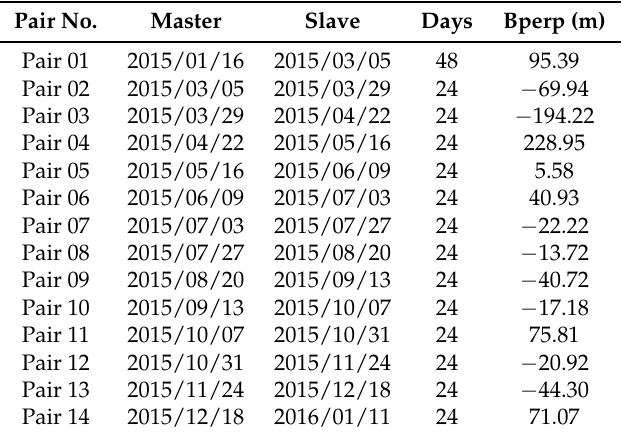
Table 3. The information of background image pairs for descending orbits. Pair